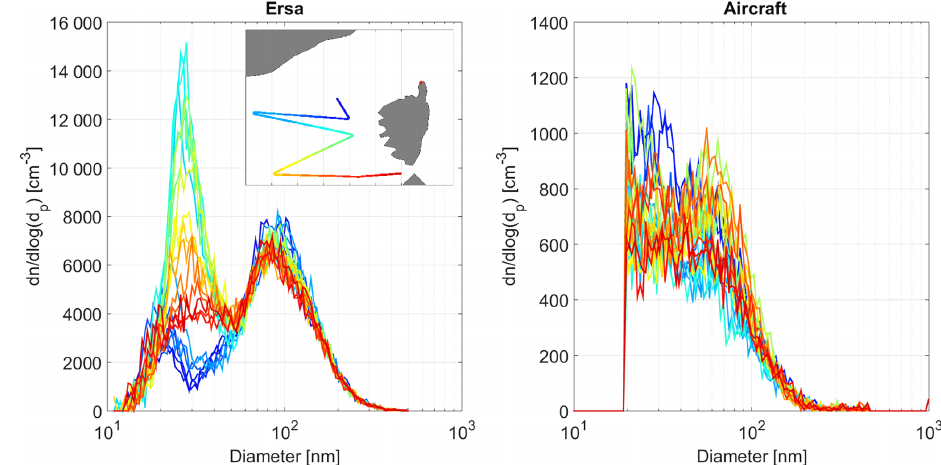
Figure 13. Ground-based (left panel) and airborne (right panel) SMPS size distributions measured on 1 August. The color coding of the spectra corresponds to the location of the aircraft, as shown on the insert of the left panel.